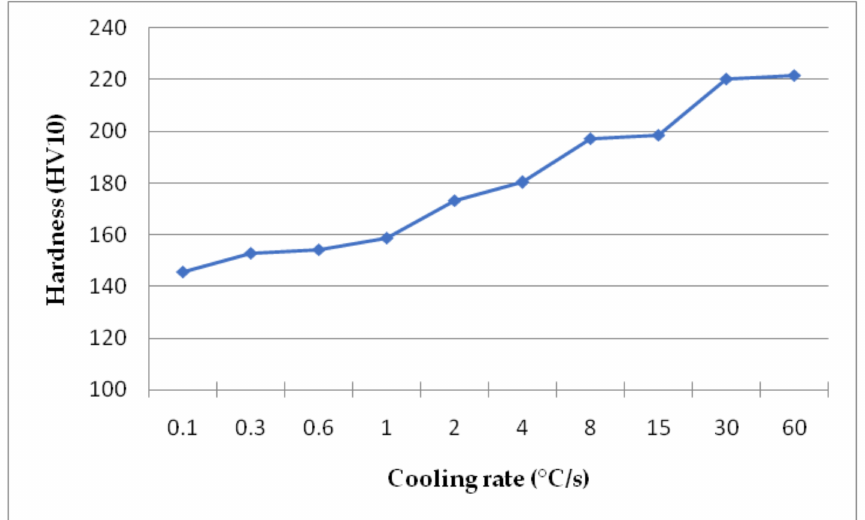
Figure 8. Hardness results for the samples cooled at different rates.